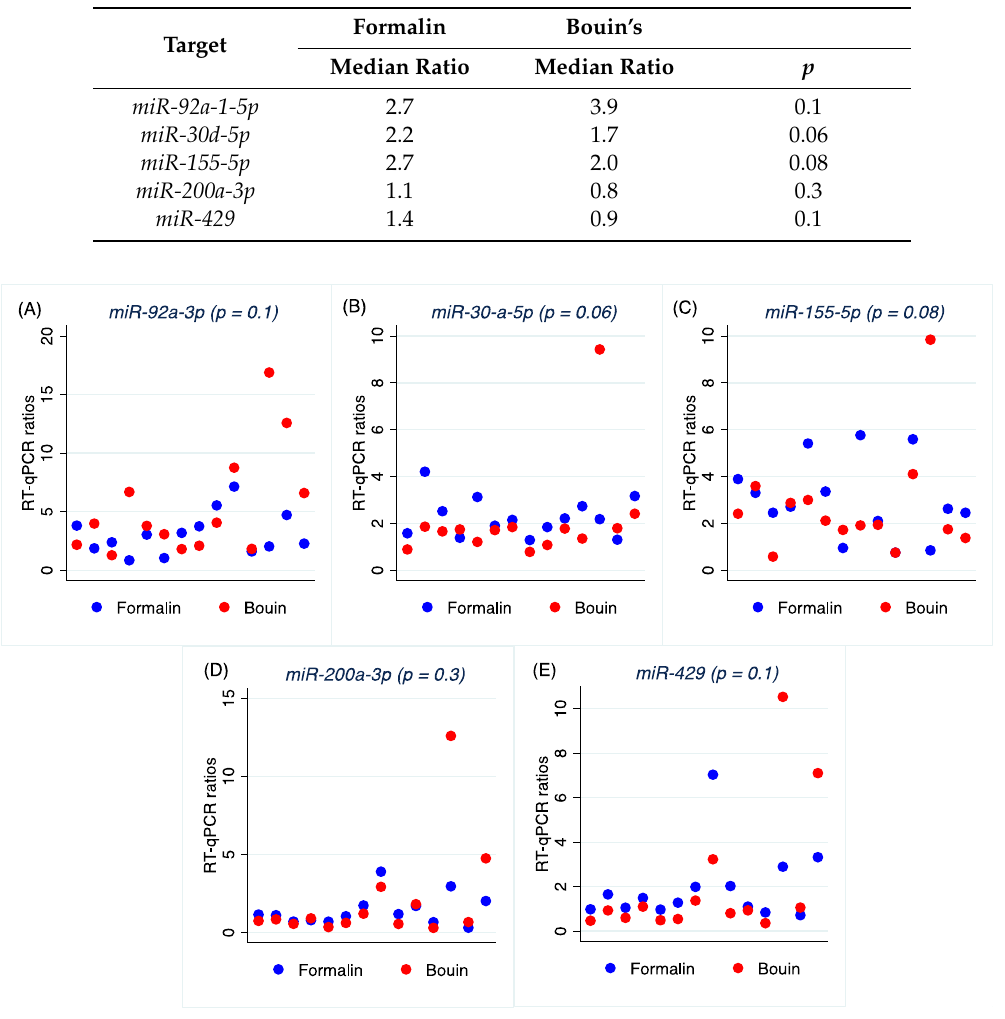
Figure 6. Scatter plot of real-time RT-qPCR ratios for miR-92a-1-5p ( A ), miR-30d-5p ( B ), miR-155-5p ( C ), miR-200a-3p ( D ), and miR-429 ( E ) in formalin- and Bouin’s-fixed tissues.